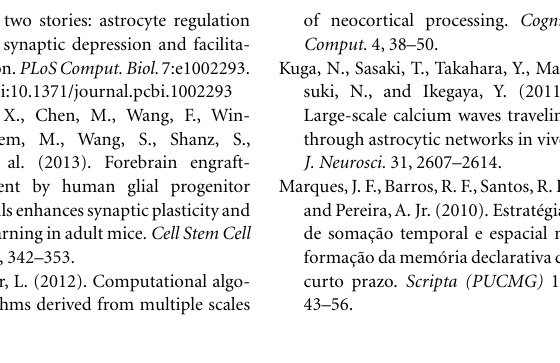
FIGURE 2 | Results of classroom experiments on declarative semantic memory formation: (A) frequency of correct answers for unrepeated relevant or irrelevant (U) and repeated irrelevant (R) sentences: (B) comparison of the average of correct answers for repeated irrelevant